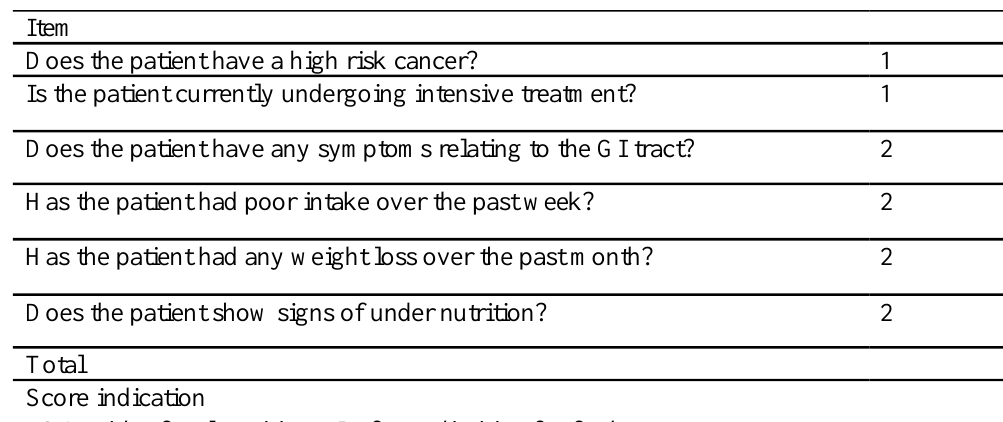
Table 2. Nutrition screening tool for childhood cancer. Adapted from Murphy et al